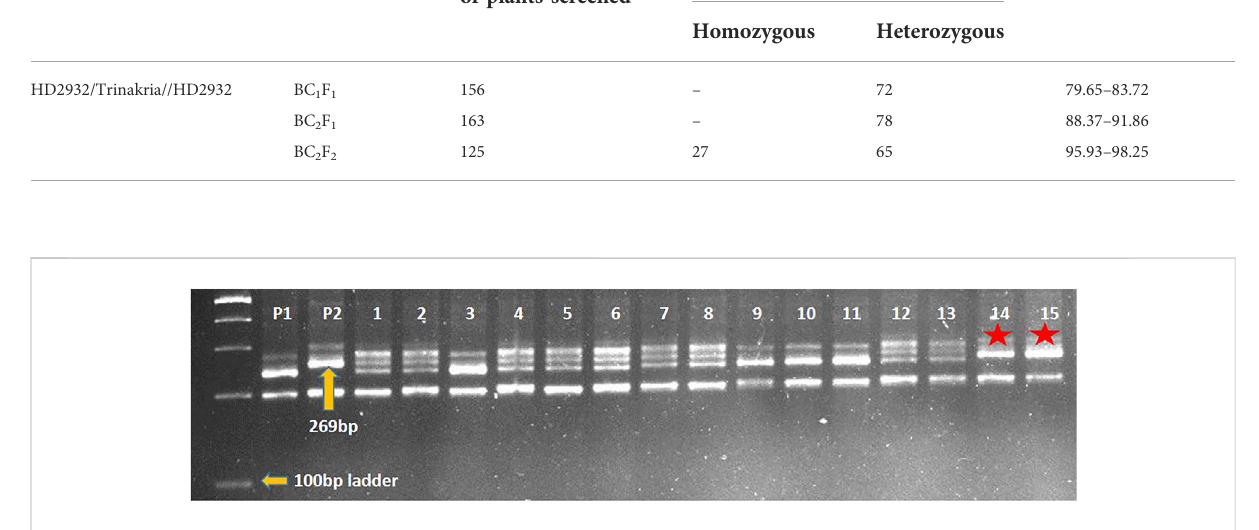
TABLE 1 Number of plants identi fi ed of carrying leaf rust resistance gene LrTrk in each backcross generations and their maximum genome recovery percentage. Cross